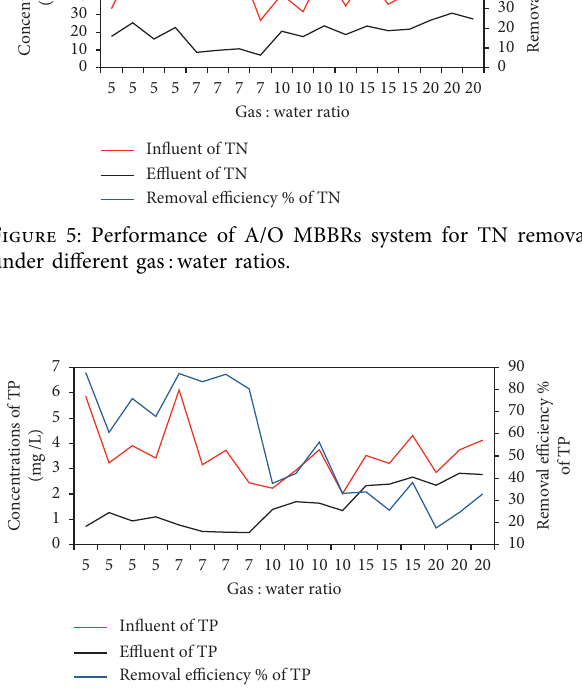
Figure 6: Performance of A/O MBBRs system for TP removal under different gas :water ratios.